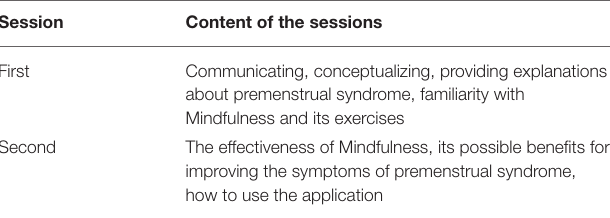
TABLE 2 | Two training sessions via Skype.